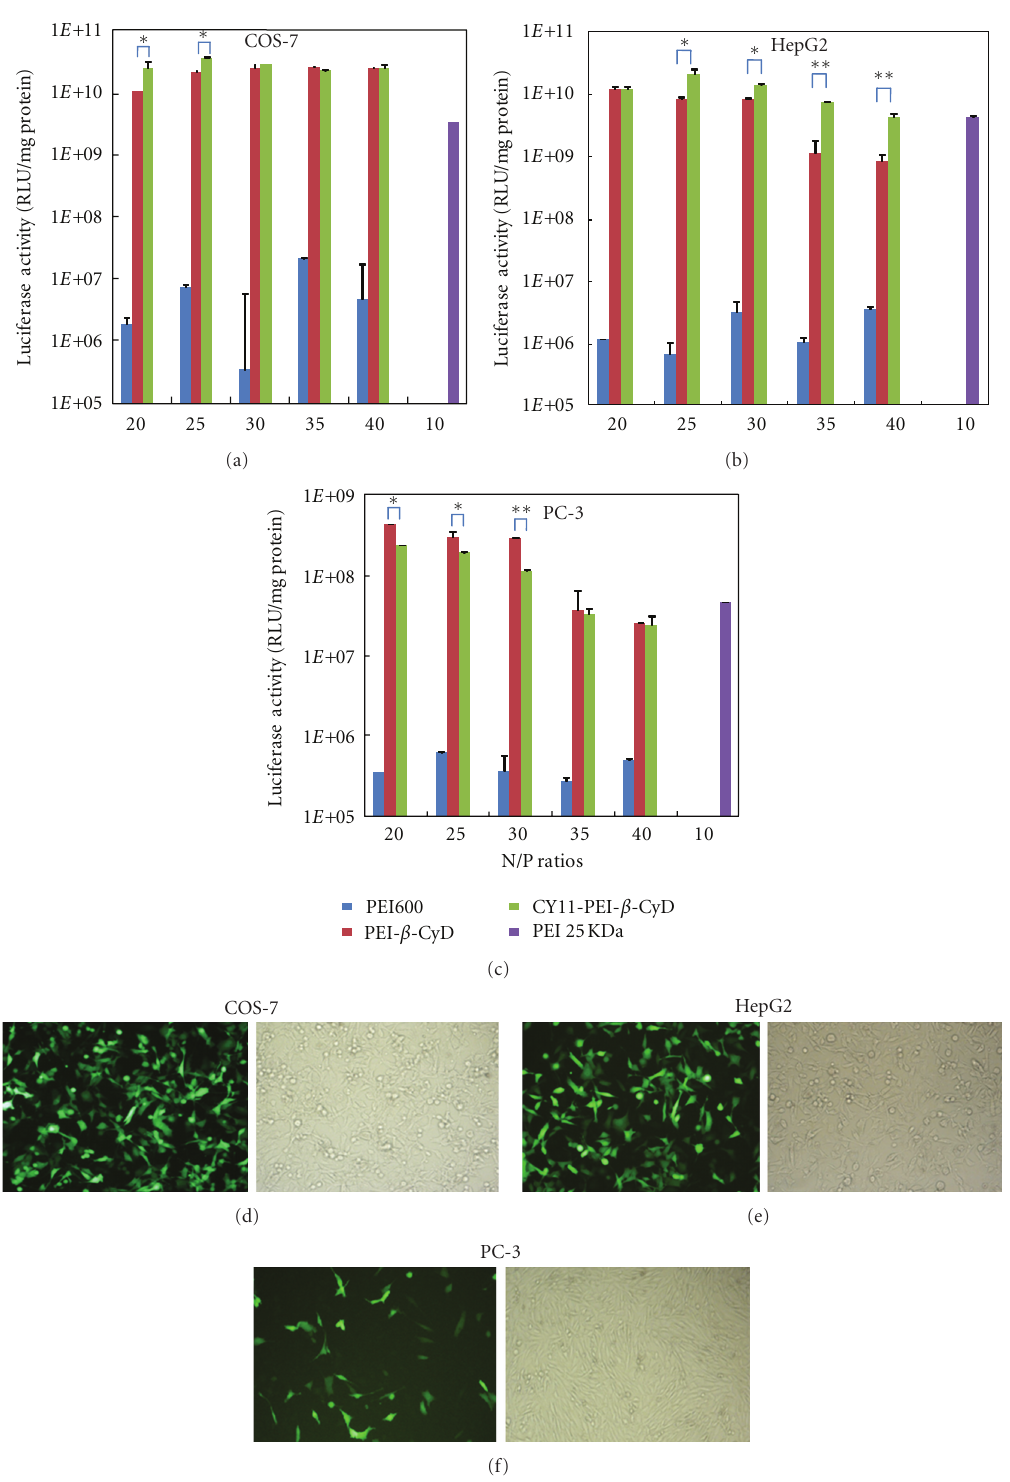
Figure 5: The gene delivery e ffi ciencies of PEI600, PEI- β -CyD, CY11-PEI- β -CyD, and PEI25KDa with di ff erent N/P ratios in (a) COS-7, (b) HepG2, and (c) PC-3 cells. PEI25KDa at an N/P ratio of 10 shows the highest gene delivery e ffi ciency. Data were shown as mean ± SD, ( ∗ P < 0 . 05 as compared with other samples in the same group). The green fluorescence emitted by green proteins expressed after the transfer of CY11-PEI- β -CyD/pEGFP at an N/P ratio of 25 to cells: (d) COS-7, (e) HepG2, and (f) PC-3 cells. A fluorescence microscope is used. Fluorescence is more evident in COS-7 (FGFR-positive) and HepG2 (FGFR-positive) cells than in PC-3 (FGFR-negative)